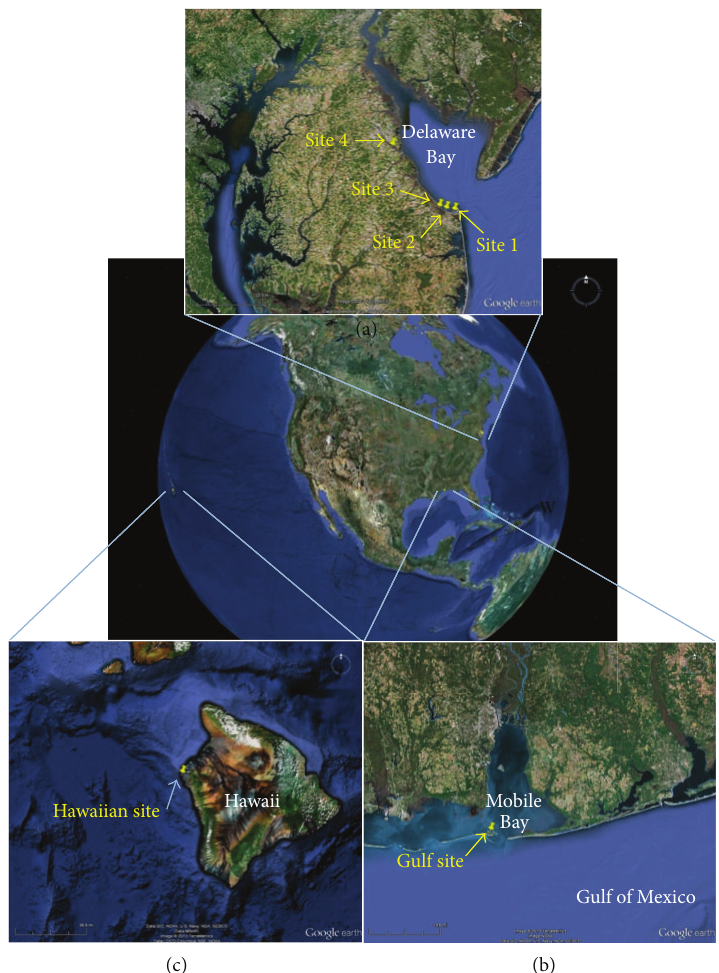
Figure 1: Sites of seawater collection along the (a) Delaware Bay, Delaware, (b) the Gulf Coast of Alabama, and (c) Keyhole Point near Kailua-Kona, Hawaii. Maps not to scale. Images were accessed through Google